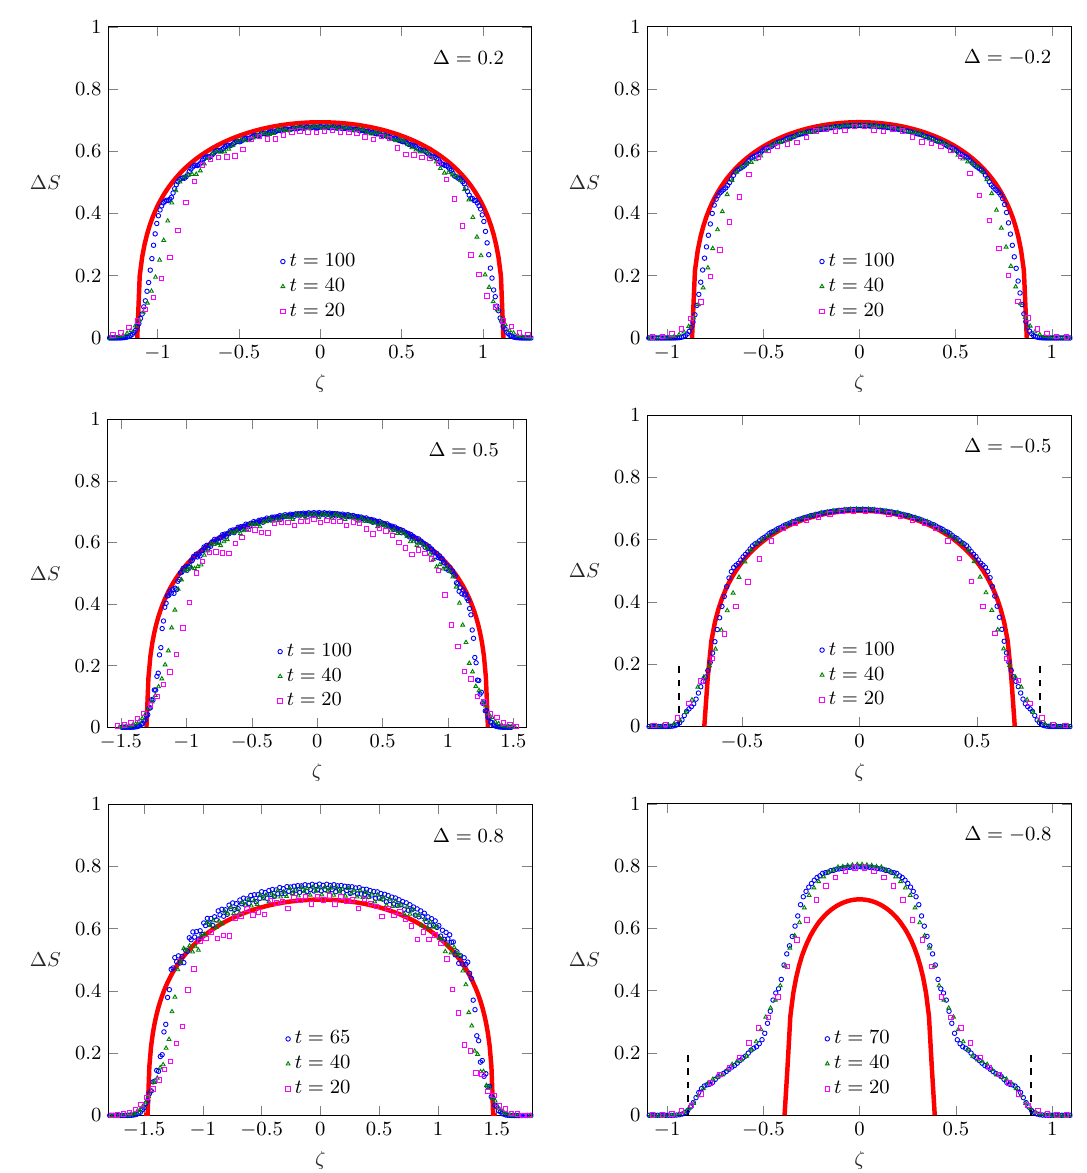
Figure 1: Excess entropy profiles ∆ S obtained from tDMRG simulations at different times (symbols), after the excitation c † in a chain of length L = 300. The scaled pro- 1 files are plotted against ζ = r / t and compared to the quasiparticle ansatz (red lines) in Eq. (17). The dashed black lines denote the maximum velocity of the particle-hole excitations, derived from Eq.